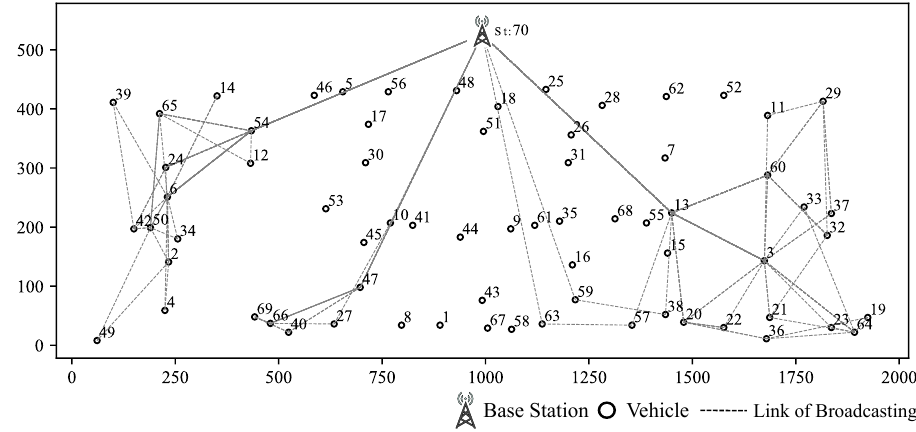
Figure 14. Sessions Uploading from Vehicles out of Base Station Communication Range.